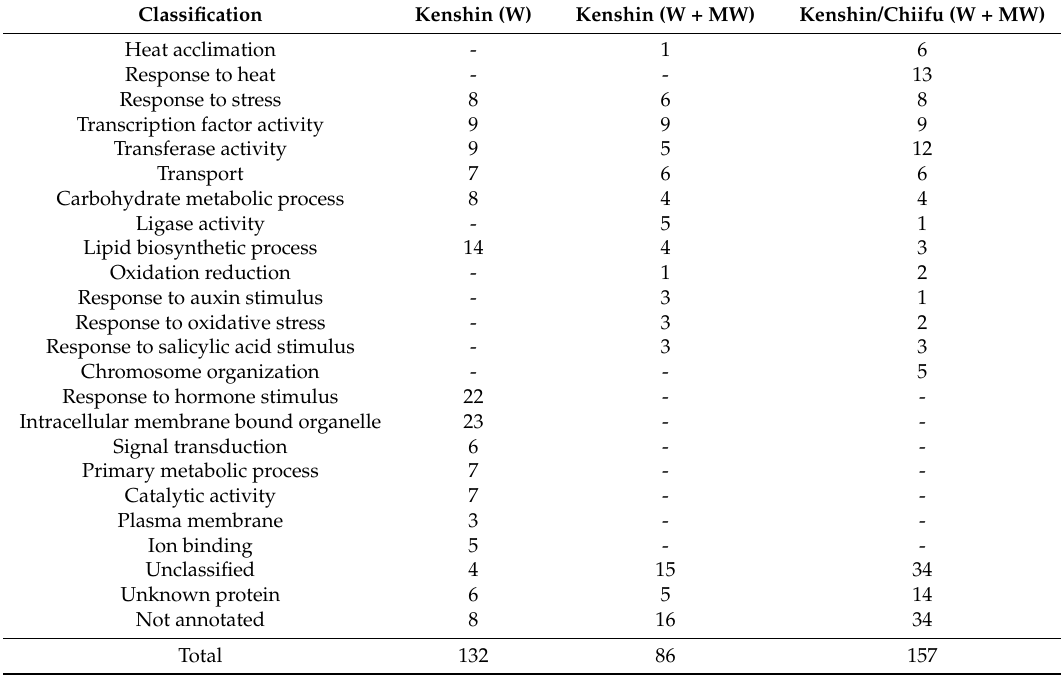
Table 2. Functional classification of genes specifically expressed in response to HT acclimation and/or adaption conditions. The table was constructed based on Tables S11–S13 using agriGO (http://bioinfo.cau.edu.cn/agriGO/) based on GO information for Arabidopsis homologs. W, warming, MW, minor